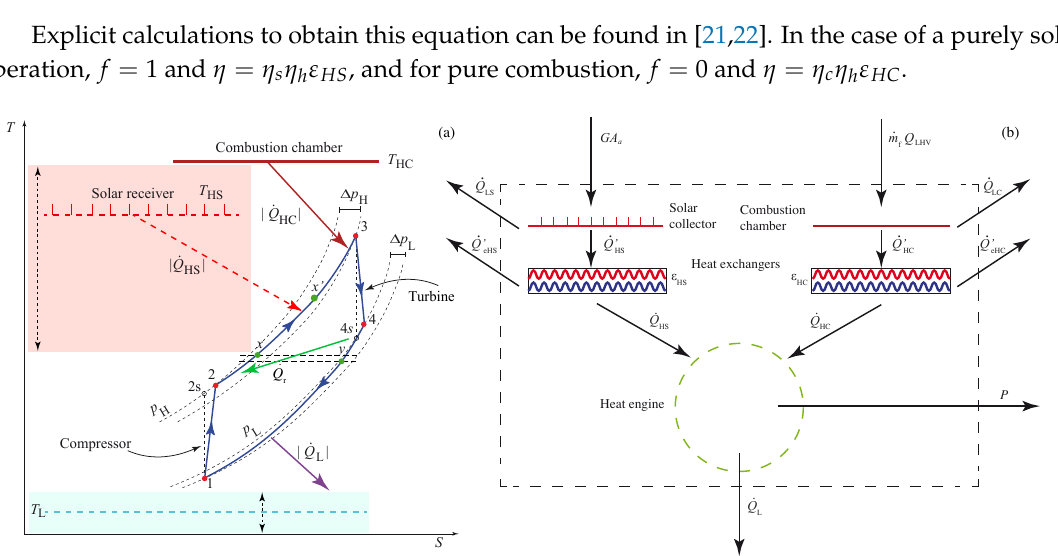
Figure 2. ( a ) T - S diagram of the Brayton cycle developed by the gas turbine. Solar receiver temperature, T HS , and ambient temperature, T L , are fluctuating quantities. ( b ) Graphical scheme of the energy flows in the whole system: solar and combustion heat inputs, heat transfers and losses in solar and combustion subsystems, and main loss sources considered in the model. Details on the thermodynamic model can be found in